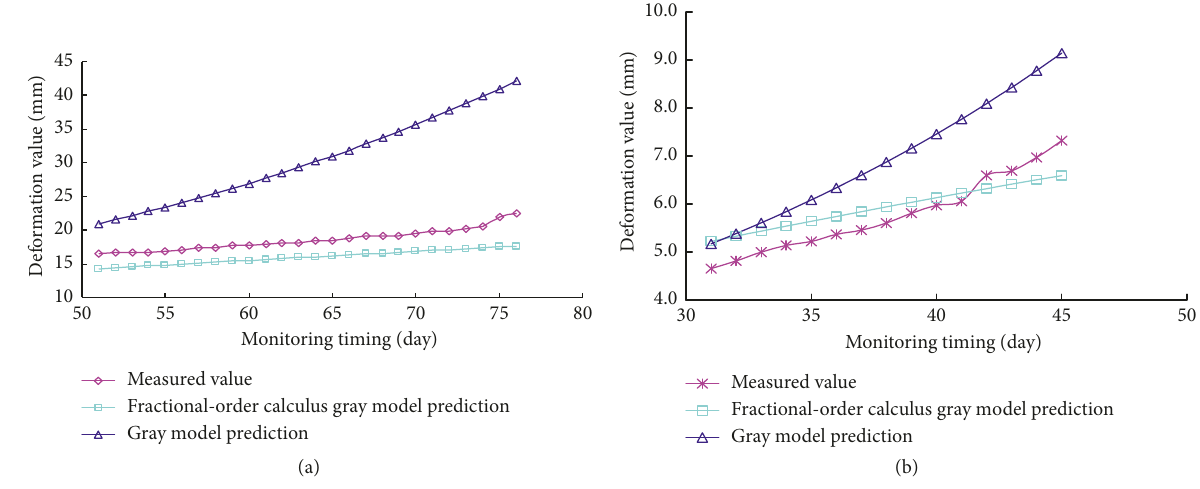
Figure 4: (a) JC-1 and (b) JC-2 monitoring point deformation